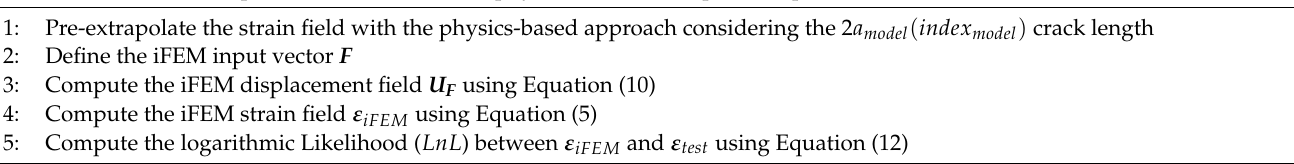
Algorithm 4: iFEM computation subroutine with physics-based strain pre-extrapolation